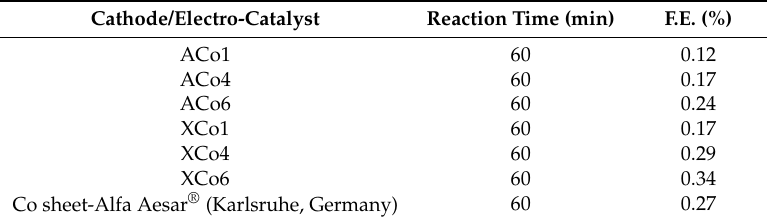
Figure 7. Molar production in the reaction versus time using xerogel based electro ‐ catalysts. Table 3. Apparent faradaic efficiencies (F.E.) for the electro ‐ catalytic CO 2 reduction at − 1.65 V vs. Ag/AgCl.